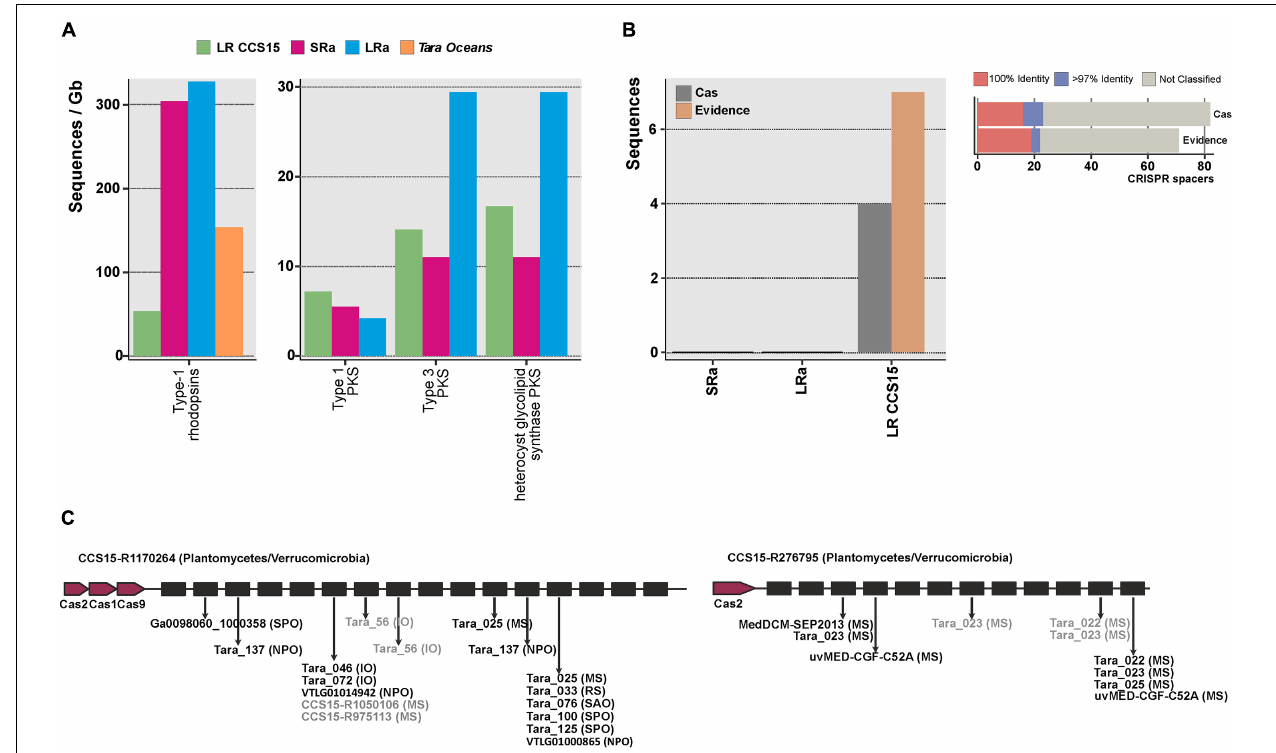
FIGURE 3 | (A) Number of type-1 rhodopsins and polyketide synthases (PKS) (left and right panels, respectively), retrieved from the LR CCS15 reads (green bar), from SRa and LRa assemblies (red and blue bars, respectively) and from Tara Oceans assemblies (orange bar). Hits are normalized by the size of the database (in gigabases). (B) Left panel, number of sequences (LR CCS15, and SRa and LRa contigs) containing CRISPR and Cas proteins (colored in dark gray) or only a CRISPR array (Evidence) with an evidence score ≥ 4 (dark orange bar). Right panel, number of CRISPR spacers classified at 100 and > 97% identity. Sequences failing the 97% identity threshold or not matching to the database are grouped into the “not-classified” bar. (C) Two examples of metagenomic reads having a CRISPR array and Cas proteins. Sequences in black and gray represent 100 and > 97% identity hits. Between brackets the isolation source of the hit: Mediterranean Sea (MS); Red Sea (RS); Indian Sea (IO), North and South Atlantic Oceans (NAO, SAO); and North and South Pacific Oceans (NPO,